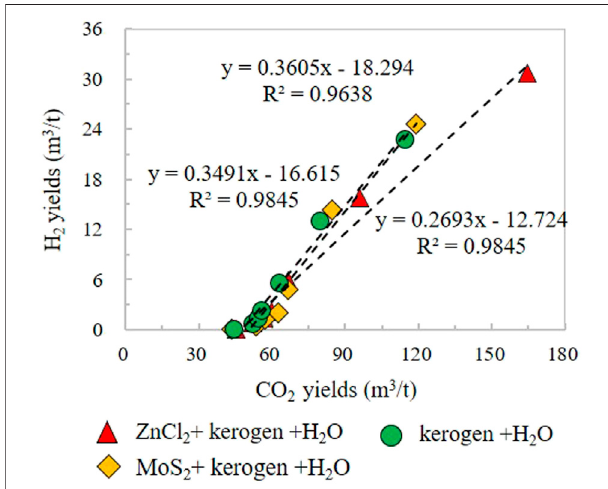
FIGURE 7 | Correlation changes of the synergistic yields between H 2 and CO 2